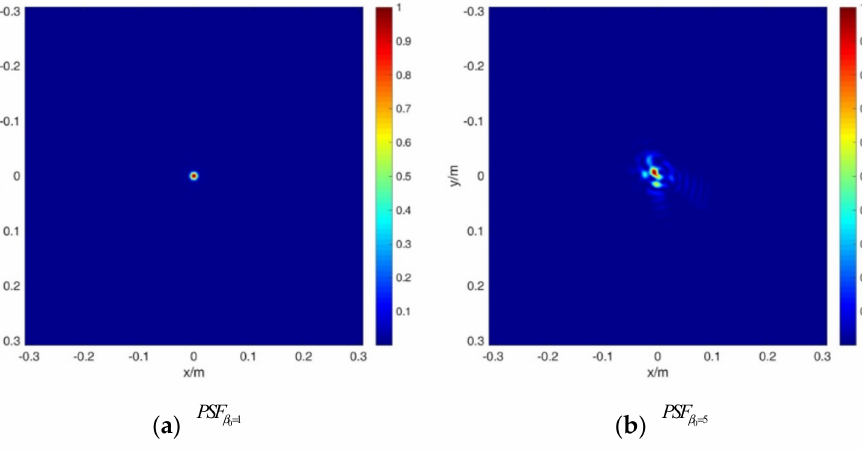
Figure 4. The PSF results for ( a ) β 0 = 1 and ( b ) β 0 =